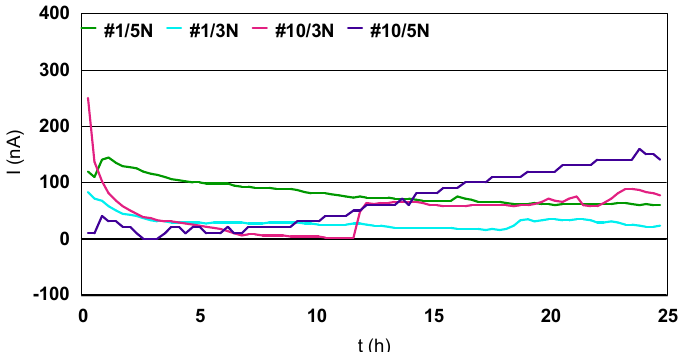
Figure 11. Galvanic currents measured in coupling #1/(3N, 5N)18K gold and #10/(3N, 5N)18K gold.